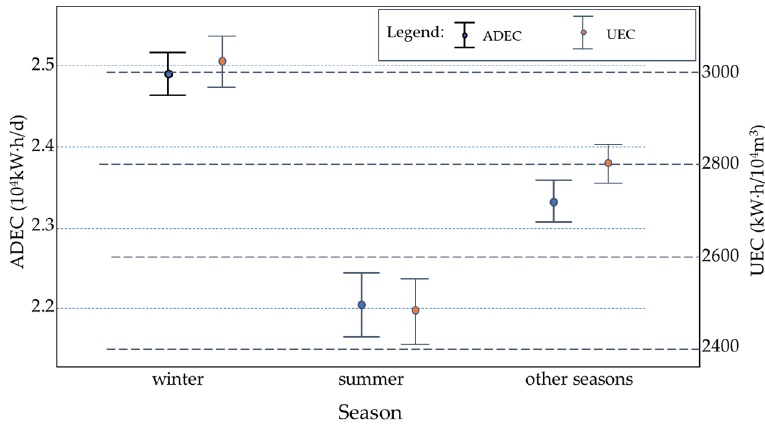
Figure 9. Relationship between electricity consumption and seasons.